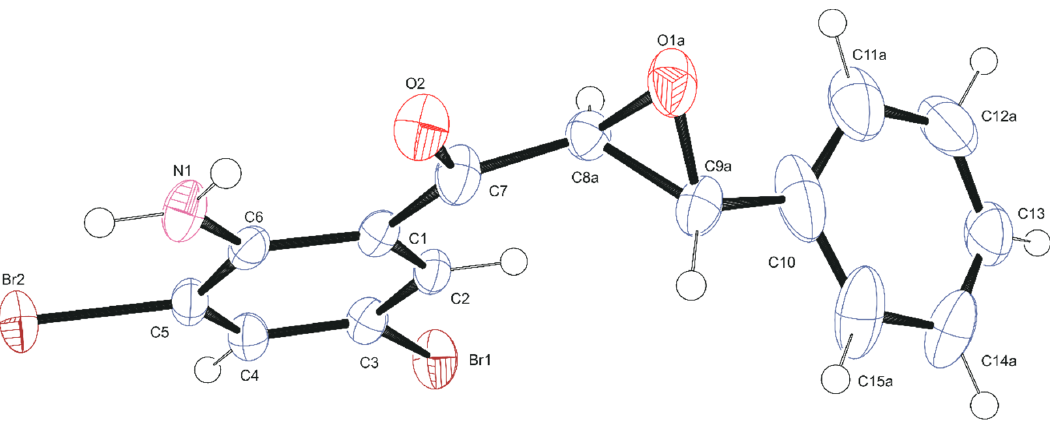
Figure 4. Oak Ridge Thermal Ellipsoid Plot (ORTEP) diagram (50% probability level) of 2a .